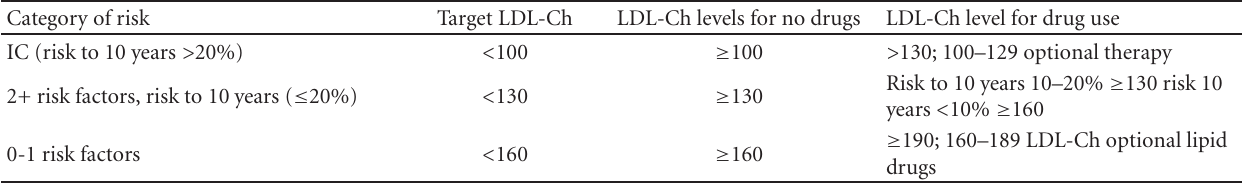
Table 3: National Cholesterol Education Program. Therapeutic target according with the lipids blood